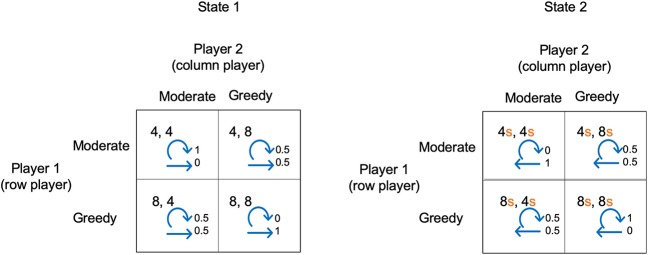
A simple stochastic game for resource competition. The players' pure strategy set is to be “Moderate” or “Greedy.” For s < 1, state 2 is the low resource state and state 1 the high resource state. Each quadrant contains the payoffs to each player, plus annotated arrows. The straight arrows are annotated with the probability of moving to the alternative state and the curved arrows are annotated with the probability of remaining in the current state.